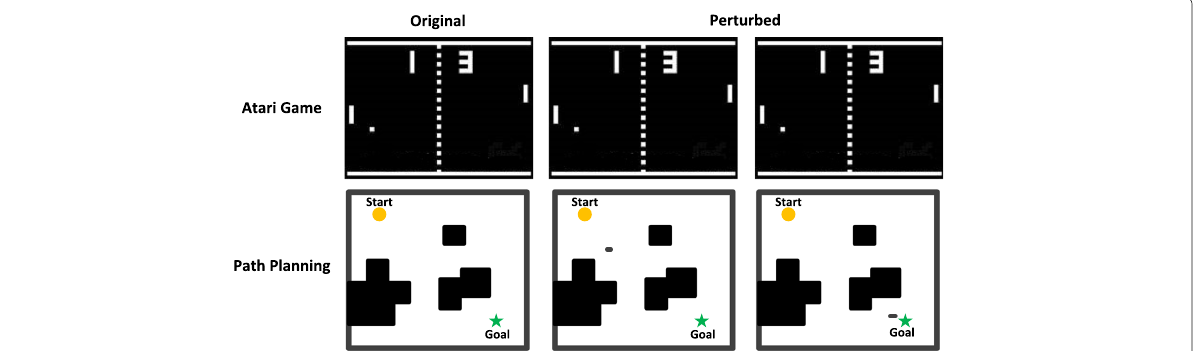
Fig. 1 Examples for adversarial attacks on reinforcement learning. As shown in the first line are the examples for adversarial attack in the field of Atari game. The first image denotes the original clean game background, while the others show the perturbed game background which can be called as “adversarial example”. Huang et al. (2017) found that the adversarial examples which are invisible to human have a significant impact on the game result. Moreover, the second line shows the examples for adversarial attack in the domain of automatic path planning. Same as the first row, the first image represents the original pathfinding map, and the remaining two images denote the adversarial examples generated by noise added. Chen et al. (2018b) found that the trained agent could not find its way correctly under such adversarial